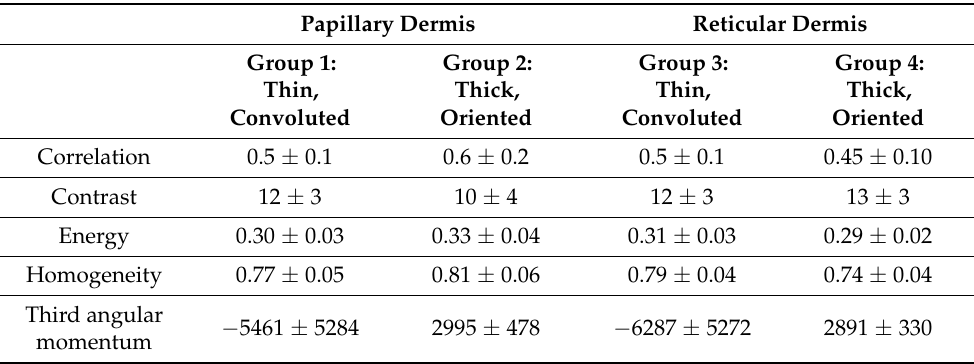
Table 3. Summary of GLCM results with Hilbert transformation. The GLCM parameters, correlation, contrast, energy, and homogeneity are shown for Hilbert-transformed thin and thick datasets in the papillary and reticular dermis. Groups 1 and 2 were extracted from a depth of 60–85 µ m on the volar forearm, and groups 3 and 4 were extracted from 85–120 µ m on the volar forearm. Papillary Dermis Reticular Dermis Group 1: